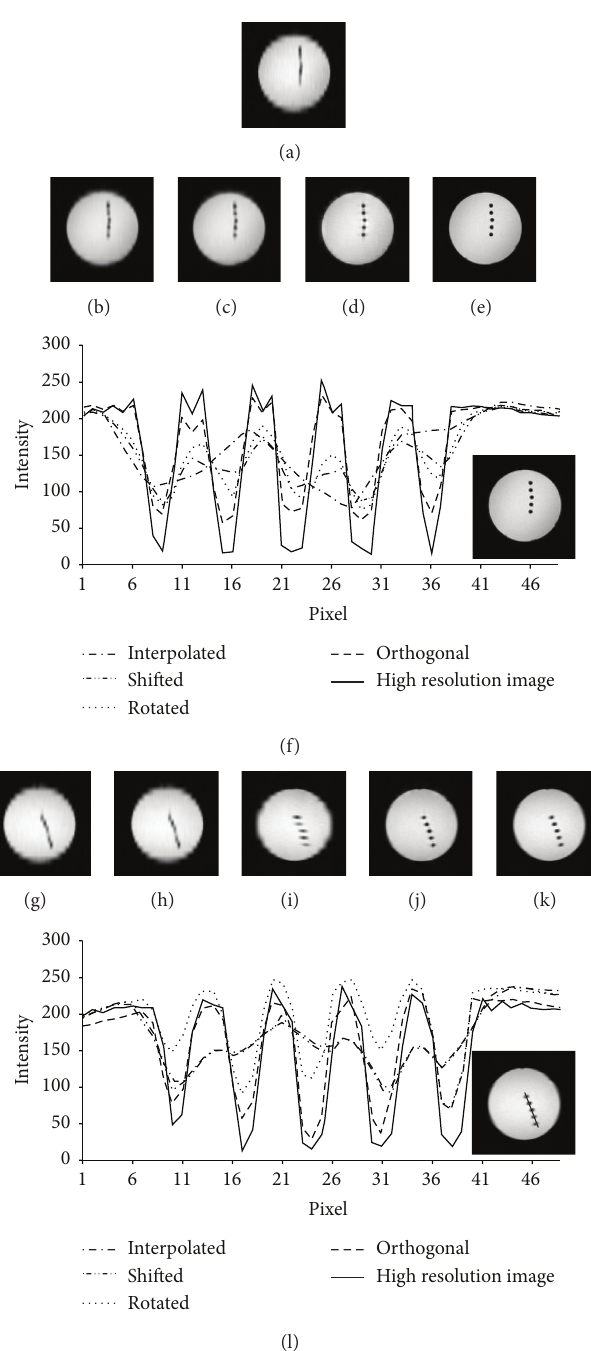
Figure 5: 2D slice images (image plane represented is orthogonal to the long axis of the tube which is placed along 𝑌 -axis in Figure 2(a)) of resolution phantom where the long axis of the tubes is orthogonal to the acquisition plane, and LR image stacks were collected with a voxel AR of 1: 1: 5: (a) interpolated, (b) shifted, (c) rotational, (d) orthogonal, (e) inplane, and (f) line plot, and where the long axis of the tubes is oblique to the acquisition plane: (g) interpolated, (h) shifted, (i) rotational, (j) orthogonal, (k) inplane, and (l) line